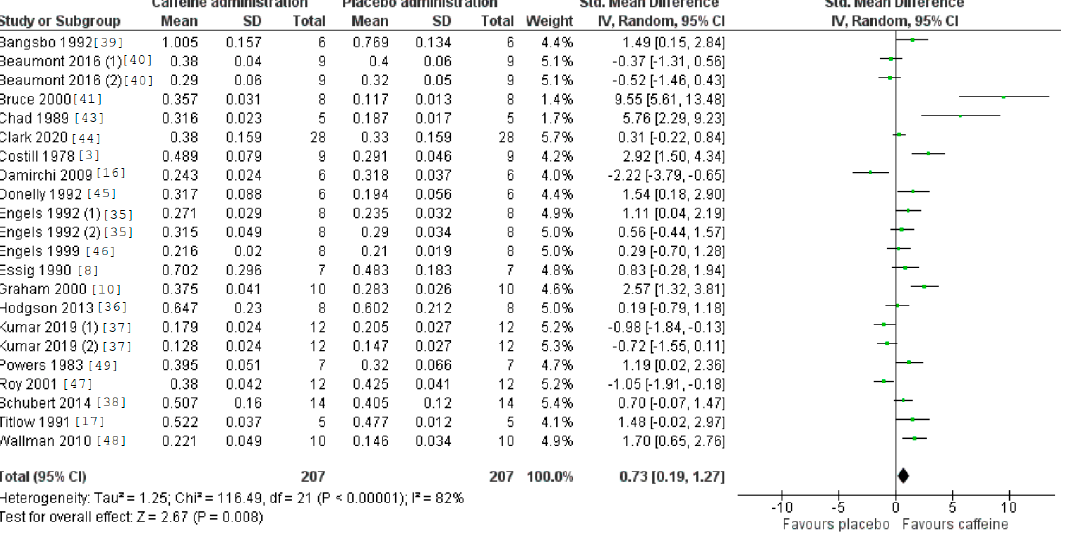
Figure 2. Effect of caffeine ingestion as compared to a placebo on fat oxidation rate during exercise. The forest plot shows standardized mean differences with 95% confidence intervals (CI) for 19 studies that included a measurement of fat oxidation rate or measurements that allowed the calculation of fat oxidation rate (i.e., oxygen uptake and respiratory exchange ratio).